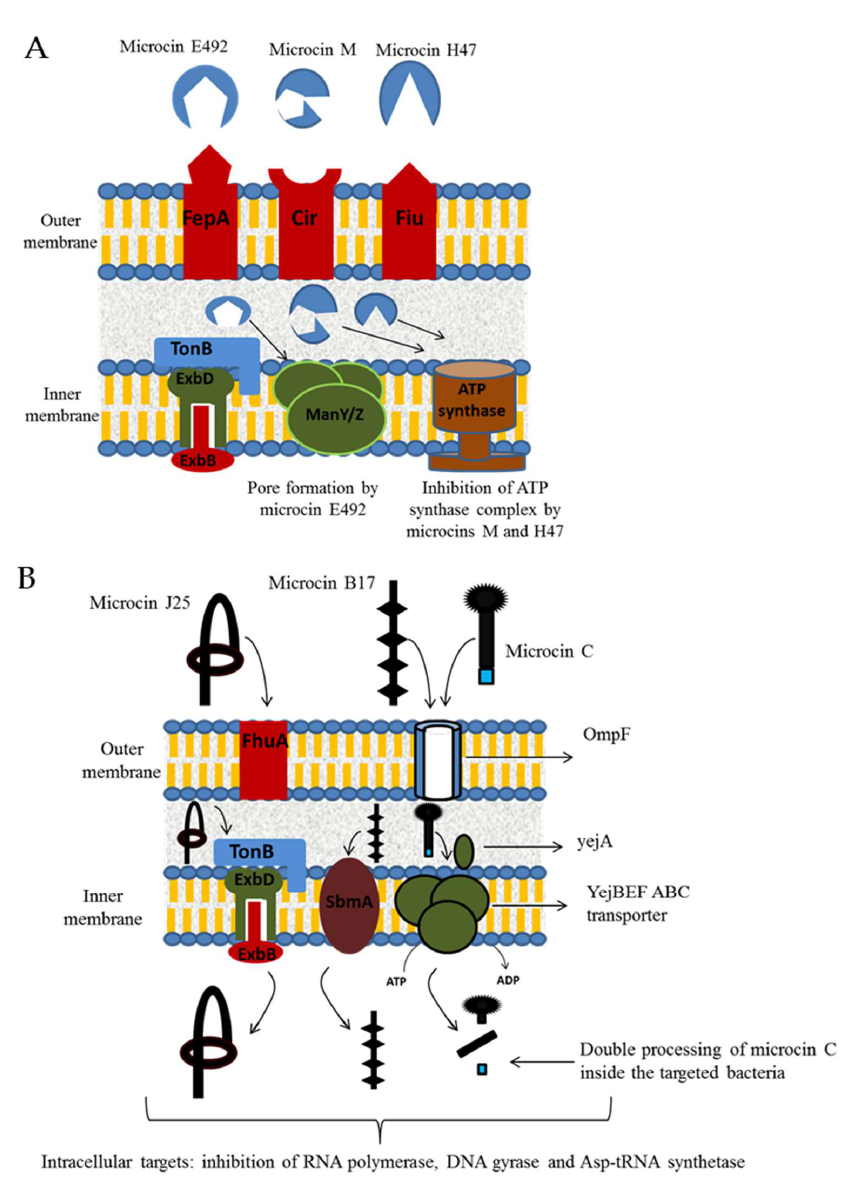
Figure 5. Mechanisms of microcins’ entry inside sensitive bacterial strains and their inner membrane ( A ) and intracellular ( B ) targets.